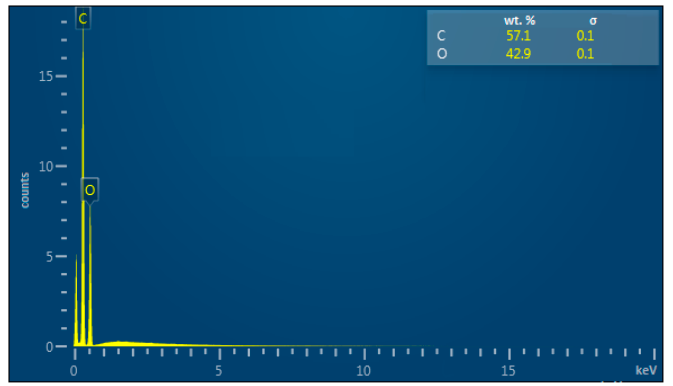
Figure 2. Elemental composition of polylactide.